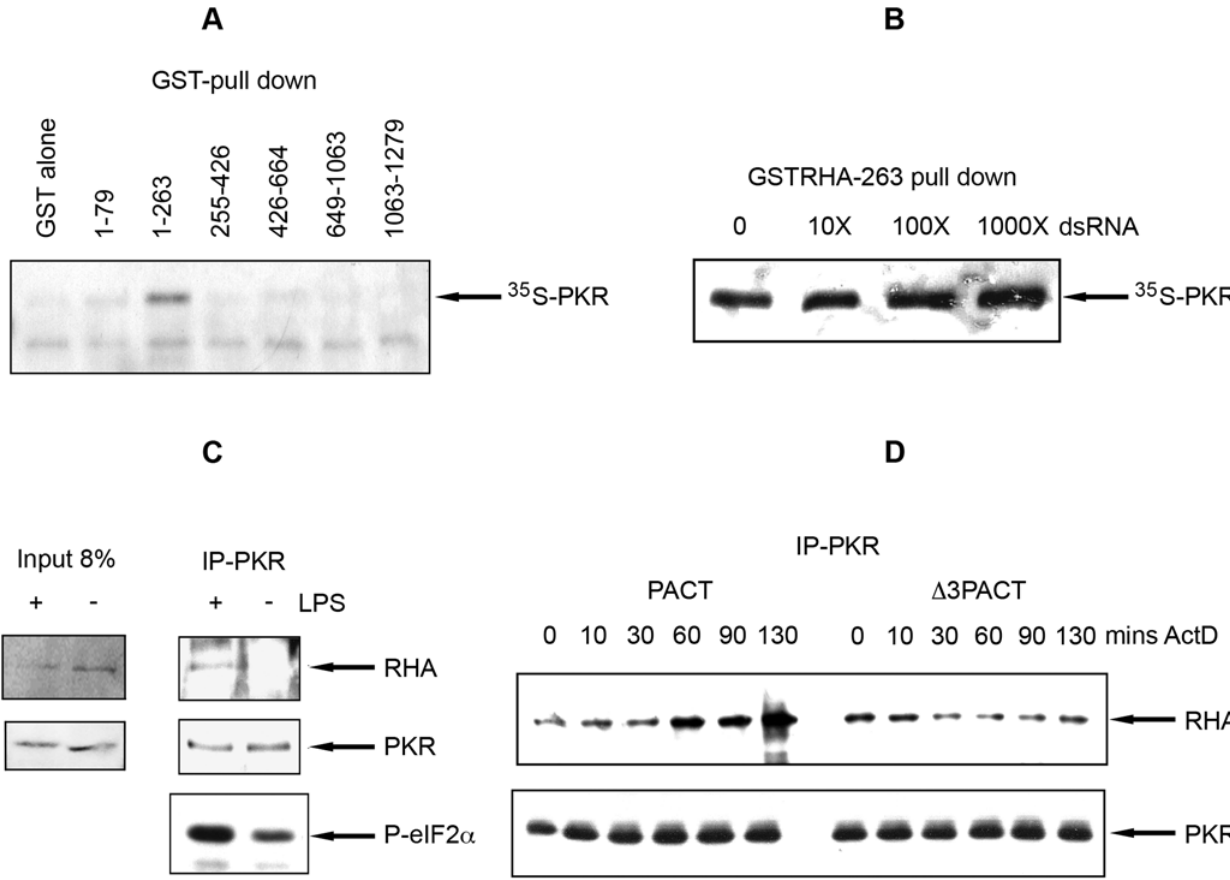
Figure 2. Activated PKR directly associates with the N-terminus of RHA. (A) An autoradiograph of 35 S-labeled PKR, pulled down with GSTRHA fusion proteins and GST alone. Amino acid end points for the RHA construct are indicated over each lane. (B) An autoradiograph of 35 S- labeled PKR pulled down with a GSTRHA fusion protein encoding amino acid residues 1 to 263 in a competitive reaction with 0, 10, 100, or 1000 fold excess of a 16 nucleotide dsRNA. (C) A Western blot of proteins immunoprecipitated with a monoclonal antibody to PKR (IP-PKR) from lysates of the human monocyte THP-I cell line, differentially treated ( + / 2 ) with LPS to activate the kinase. Proteins are detected with rabbit anti-RHA (top panel) or mouse anti-PKR (middle panel). Activation of PKR was confirmed by detection with a rabbit anti-phosphoS51-eIF2 a (P-eIF2 a ; bottom panel). (D) A Western blot of proteins immunoprecipitated with a monoclonal antibody to PKR (IP-PKR) from lysates of HEK293T transfected with HA-tagged RHA and PACT or the deletion construct D 3PACT and temporally treated with actinomycin-D (mins ActD) to activate PKR. Proteins were detected with a rabbit anti-HA (RHA; top panel) and mouse anti-PKR antibody (bottom panel).